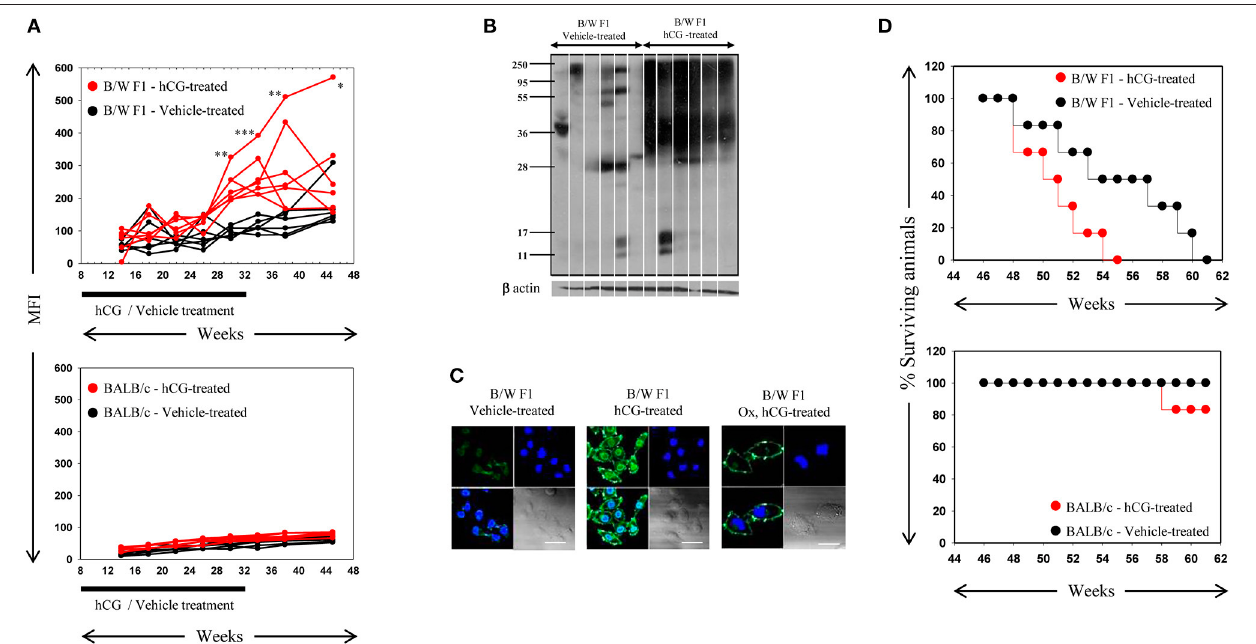
FIGURE 2 | : Analysis of antibodies in the sera of B/W F1 and BALB/c mice. (A) Kinetics of Mean Fluorescence Intensities (MFI) upon flow cytometric analysis to assess reactivity of antibodies in the sera of vehicle-treated (black lines) and hCG-treated (red lines) B/W F1 (Top) and BALB/c (Bottom) mice toward permeabilized CCL131 cells. The duration of treatment is indicated. Each line represents an individual animal. * p < 0.05, ** p < 0.01, *** p < 0.001: Vehicle-treated vs. hCG-treated B/W F1 mice at respective time-points. (B) Reactivity of antibodies in sera derived from individual B/W F1 (vehicle-treated and hCG-treated, Week 38) mice toward CCL131 cellular lysate by Western blot. Each lane represents an individual animal. Anti- β actin antibodies were employed to verify equivalence of loading. (C) Confocal immuno-fluorescence analysis of the reactivity of antibodies in pooled sera obtained from B/W F1 (vehicle-treated and hCG-treated, Week 38) mice toward CCL131 cells. Reactivity of antibodies in sera of ovairectomized (Ox), hCG-treated B/W F1 mice is also shown. Top right panels, DAPI; Top left panels, Antibody reactivity; Bottom left panels, Overlays; Bottom right panels: DIC. Bars: 20 µ m. (D) Top panel: Kalpan-Meier analyis depicting the survival of vehicle-treated (black lines) and hCG-treated (red lines) B/W F1 mice. p < 0.002, vehicle-treated vs. hCG-treated mice. Bottom panel, Kalpan-Meier analyis depicting the survival of vehicle-treated (black lines) and hCG-treated (red lines) BALB/c mice.